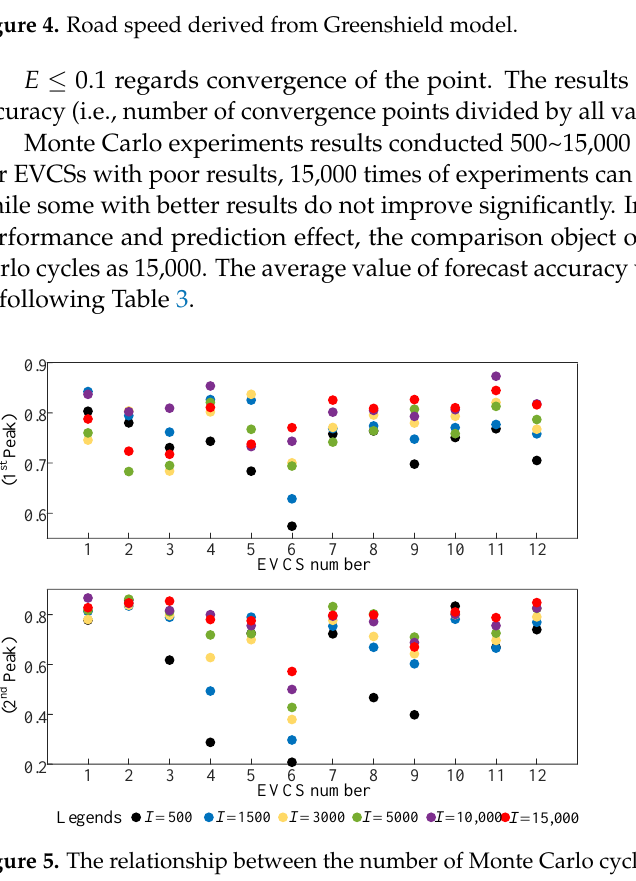
Figure 5. The relationship between the number of Monte Carlo cycles and forecast accuracy. Table 3. Average prediction accuracy under different Monte Carlo cycles.